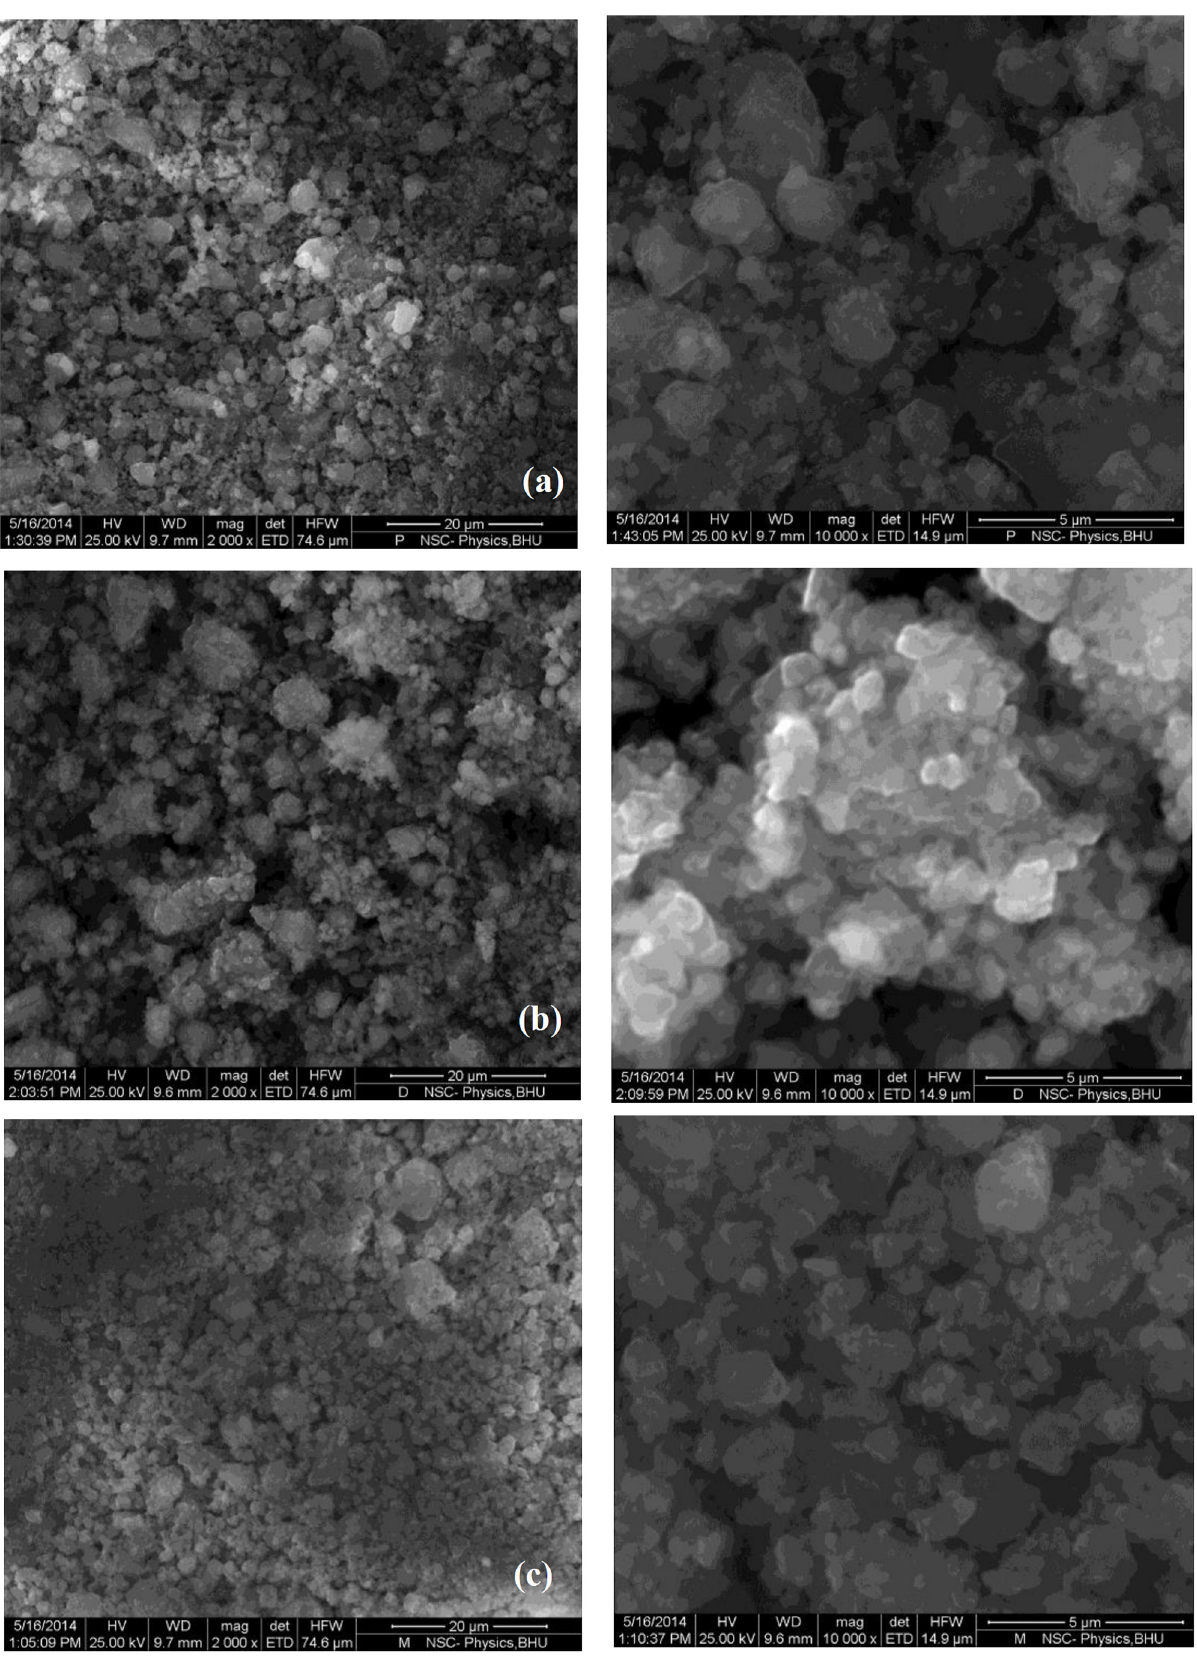
Figure 4. SEM images for MgH 2 + 5 mol % MgF 2 in ( a ) desorbed state and ( b ) re-hydrogenated state in comparison to ( c ) pure MgH 2 .